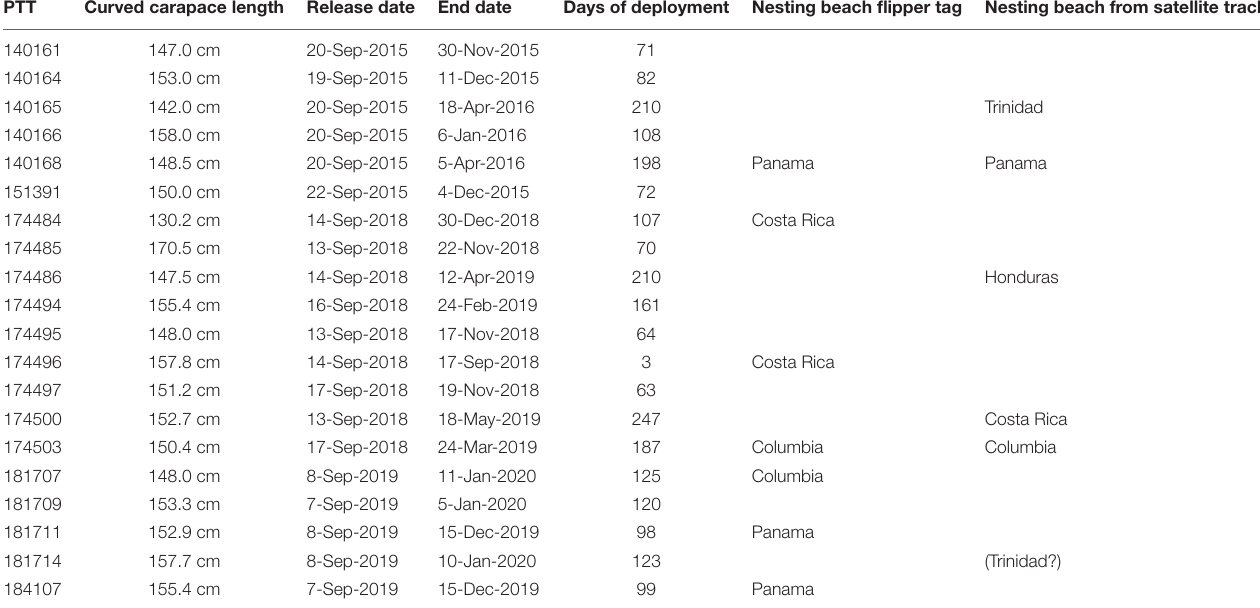
Tag 181714 stopped transmitting before nesting but she was off the north coast of Trinidad.